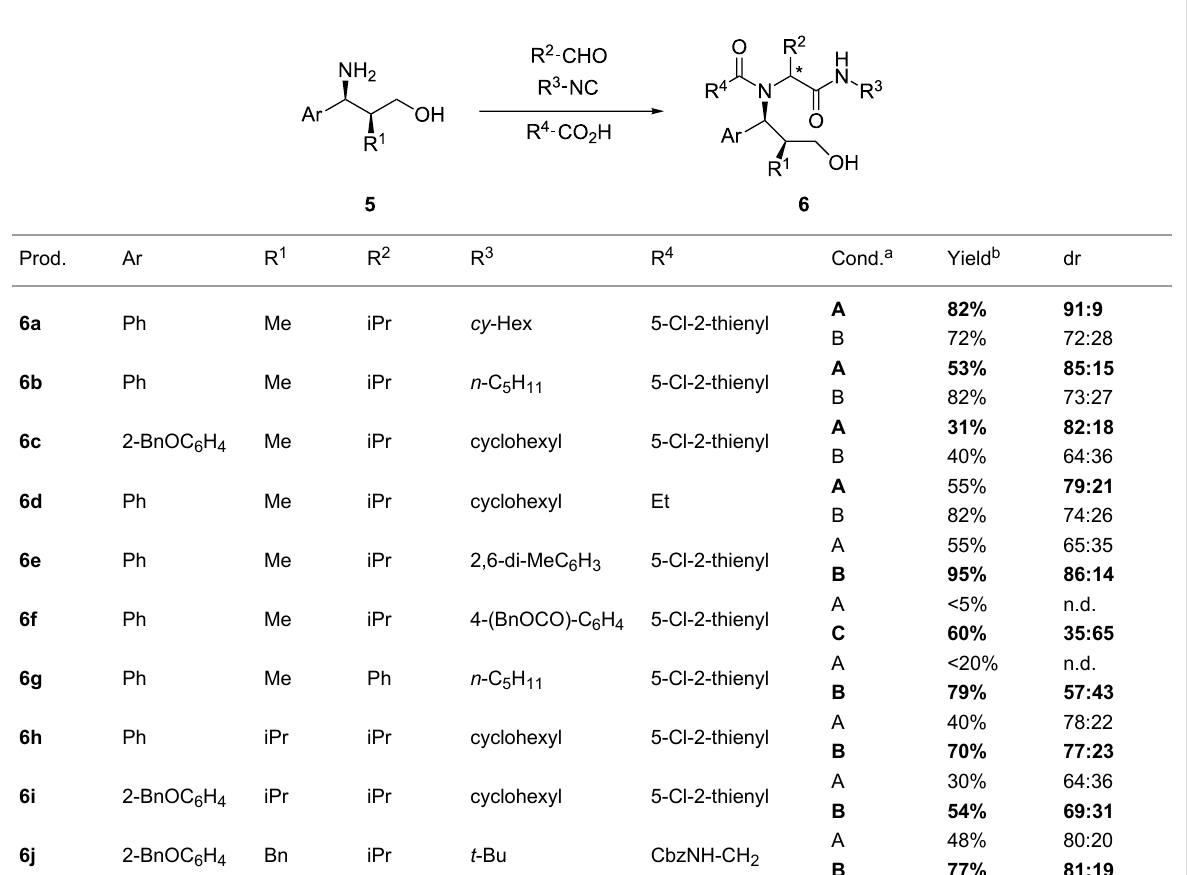
Table 2: Scope of the synthesis of Ugi adducts 6 .